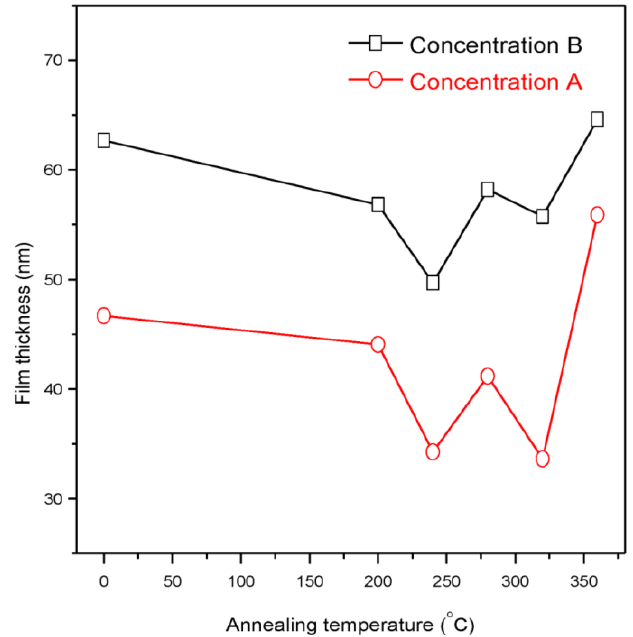
Figure 2. Variation of film thickness with different annealing temperatures.